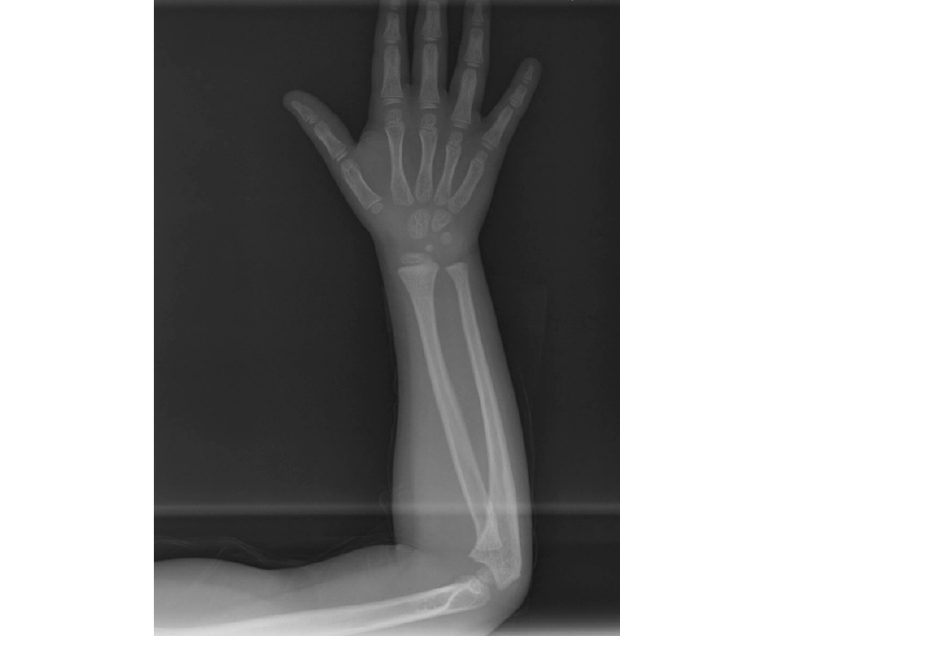
Figure 3. Hand-wrist and long bone radiographic presentation of the daughter exhibiting no osseous defects.